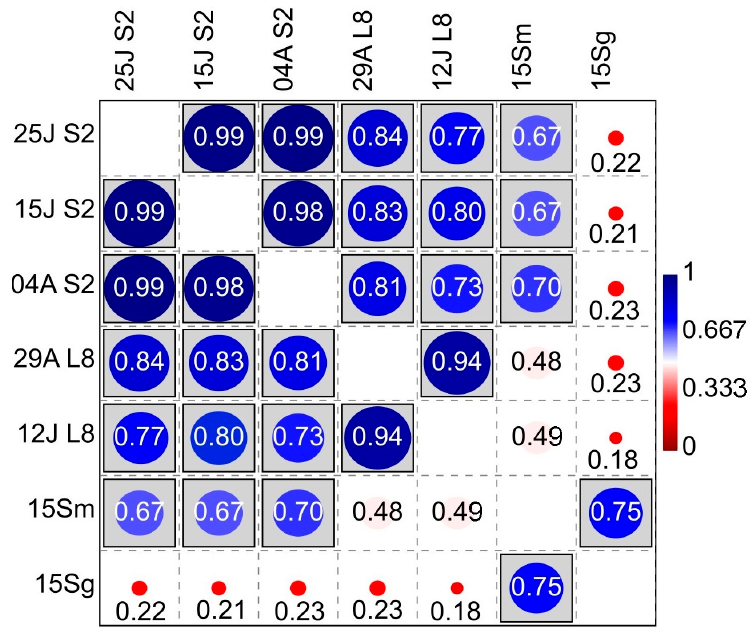
Figure 7. Correlations (Pearson’s r). Analysed factors: Sentinel-2 NDVI (S2), dates: 4 August, 25 July, and 15 July. Landsat-8 NDVI (L8), dates: 29 August and 12 July. Yeast species richness in grapes (15Sg) and musts (15Sm). Statistical ‘linear r (Pearson) and p(uncorr)’ table format: significance at p < 0.05 is